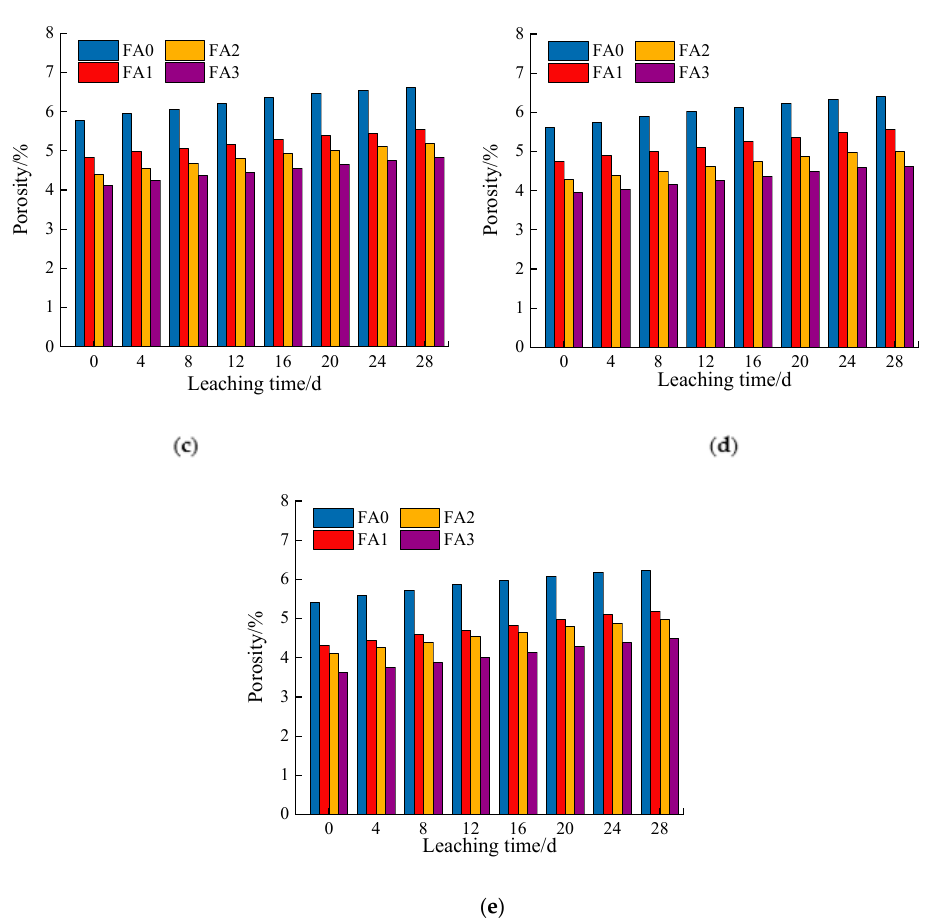
Figure 9. Porosity changes of samples with different fly ash contents: ( a ) cement content: 3%; ( b ) cement content: 4%; ( c ) cement content: 5%; ( d ) cement content: 6%; ( e ) cement content: 7%.